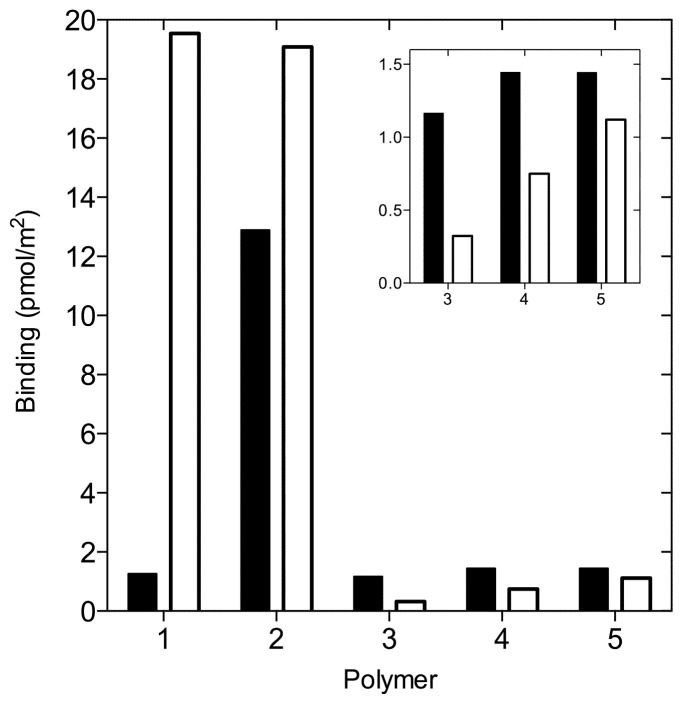
Polymer-warfarin binding data. Filled bars correspond to warfarin binding to the MIP whereas open bars correspond to warfarin binding to the REF polymer. Normalized binding data (PC50) is scaled with the corresponding swelling corrected polymer surface area, Asw (Equation 2).